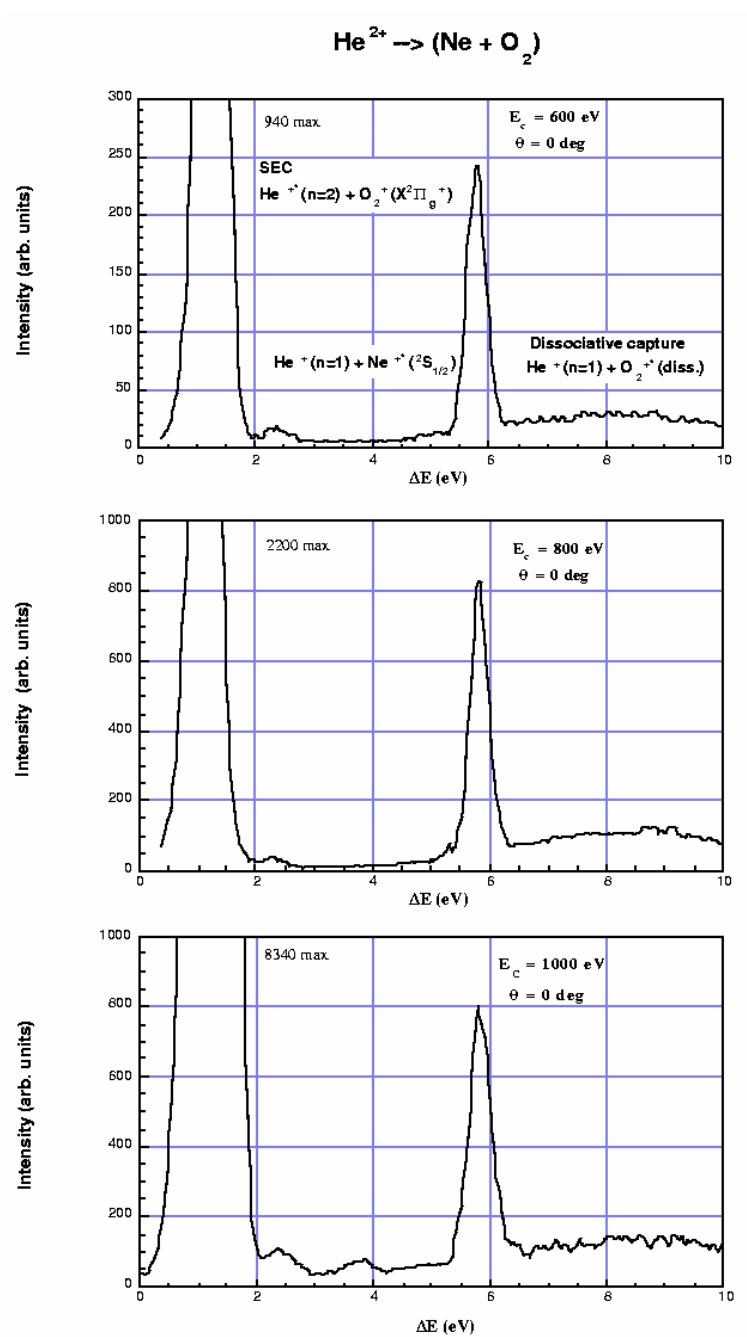
collisions; the peak near 6 eV results from 2